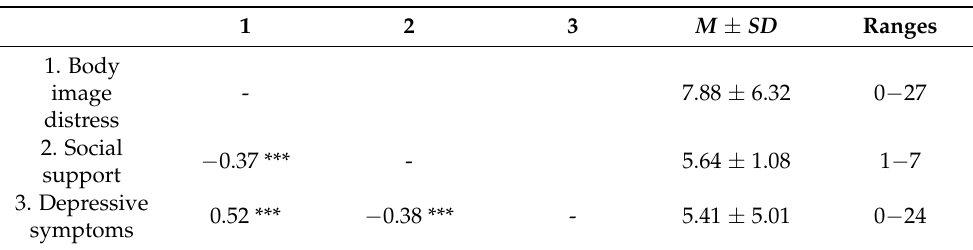
Table 2. Descriptive statistics and bivariate correlations between body image distress, social support, and depressive